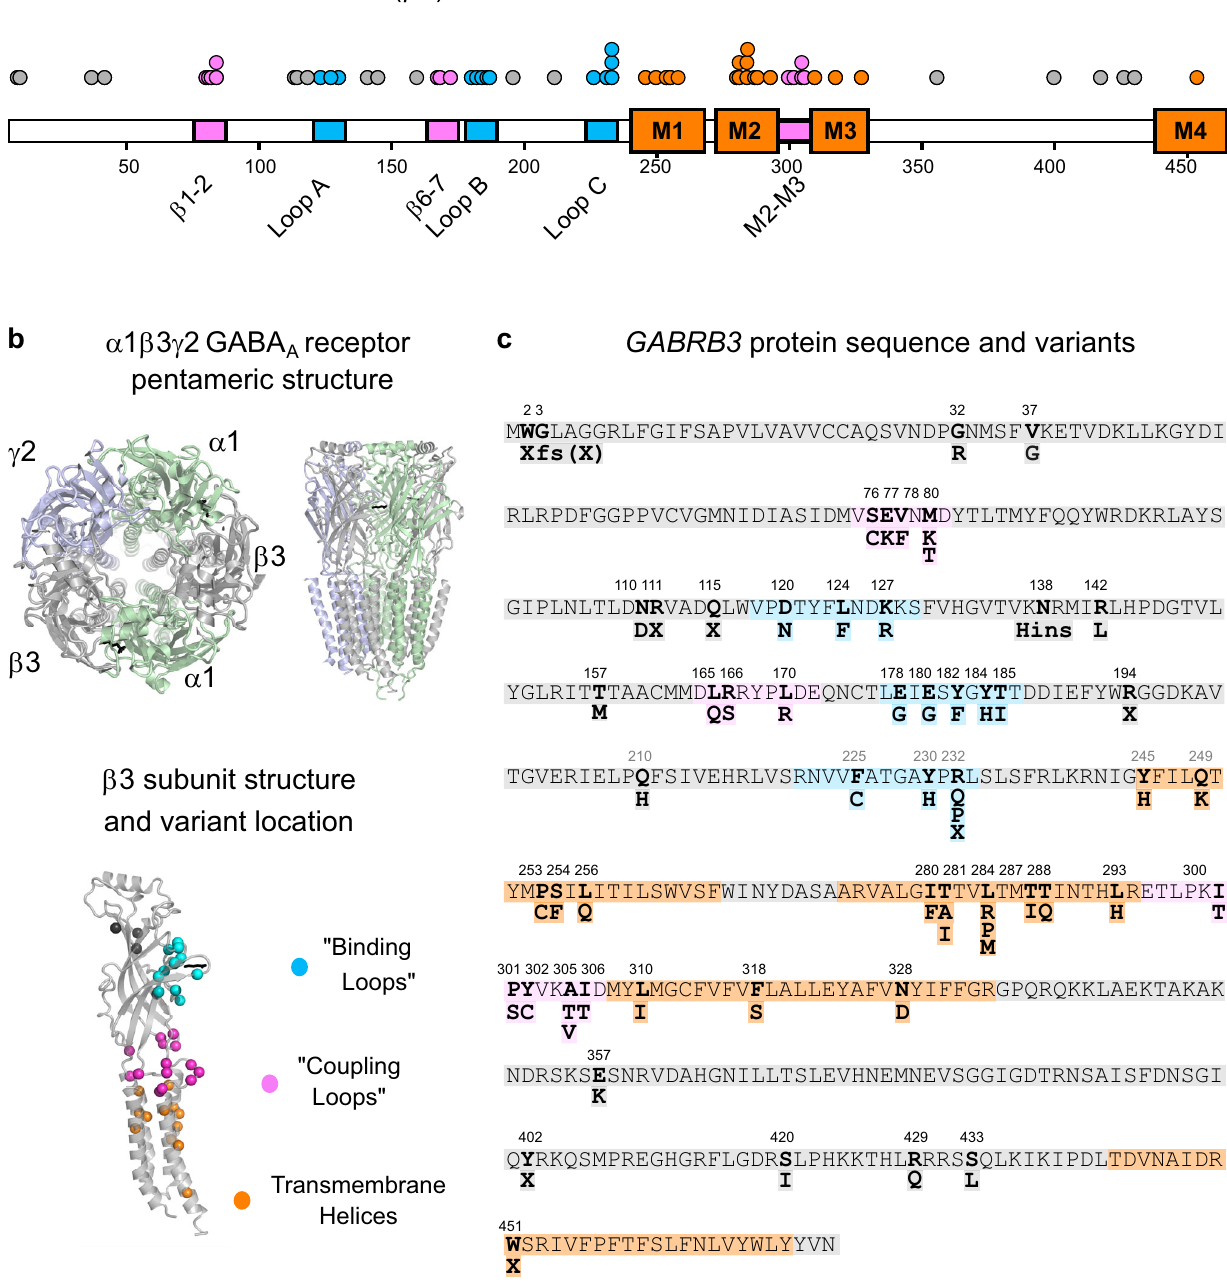
Fig. 1 GABRB3 epilepsy-associated variants. a Two-dimensional representation (top) of a GABA A receptor β 3 subunit (pdb:6hup) 15 highlighting binding loops (blue), coupling loops (pink) and four transmembrane regions (orange). Dots represent individual variants associated with DEE. b 3D cartoon structure of the pentameric α 1 β 3 γ 2 GABA A receptor from above and the side. α 1 (pale green) β 3 (silver) and γ 2 (light purple) subunits are colour coded and the GABA molecule is represented as black sticks. A 3D cartoon structure of a β 3 subunit showing the location of variants as spheres coloured by their location in the binding loops (blue), coupling loops (pink), transmembrane regions (orange) or elsewhere (dark grey). c The GABRB3 sequence is shown with missense amino acid variants numbered and in bold. Structural features of the binding, coupling loops and transmembrane regions are